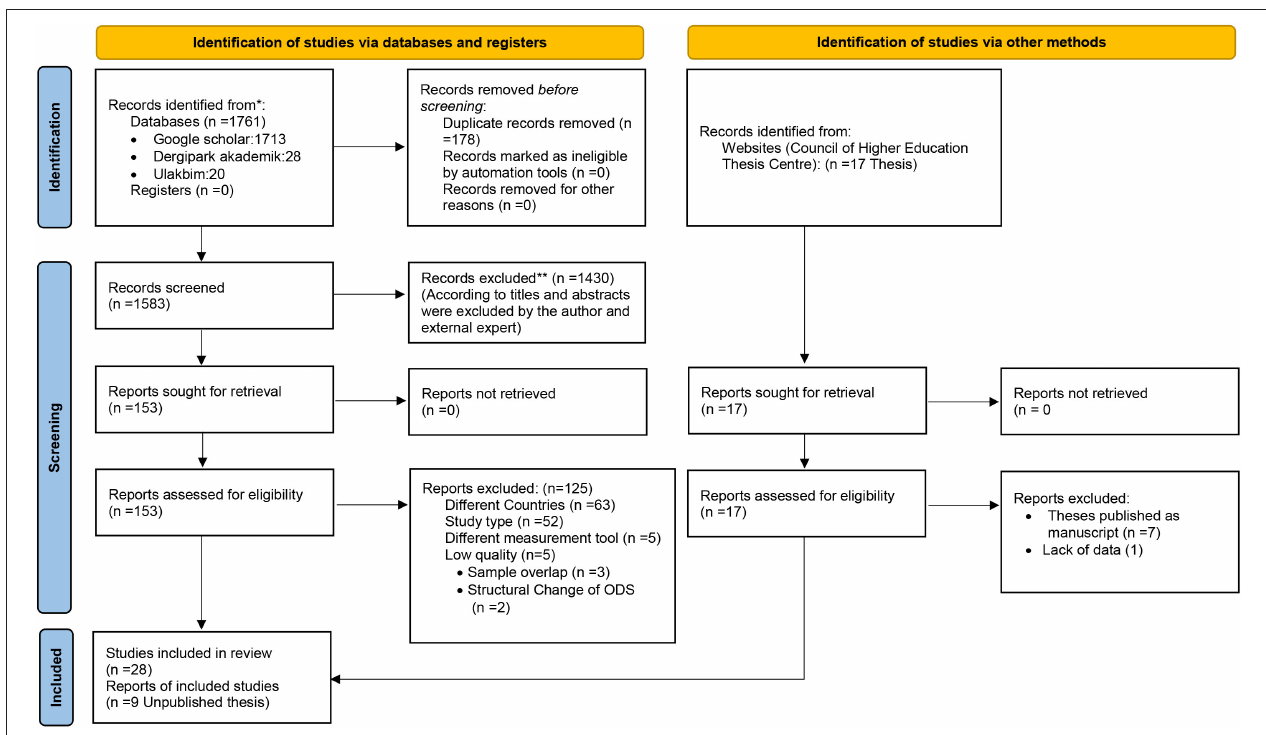
FIGURE 1 | PRISMA 2020 flow diagram: Selection and inclusion process of studies for systematic reviews. *Consider, if feasible to do so, reporting the number of records identified from each database or register searched (rather than the total number across all databases/registers). **If automation tools were used, indicate how many records were excluded by a human and how many were excluded by automation tools. Adapted from Page et al.